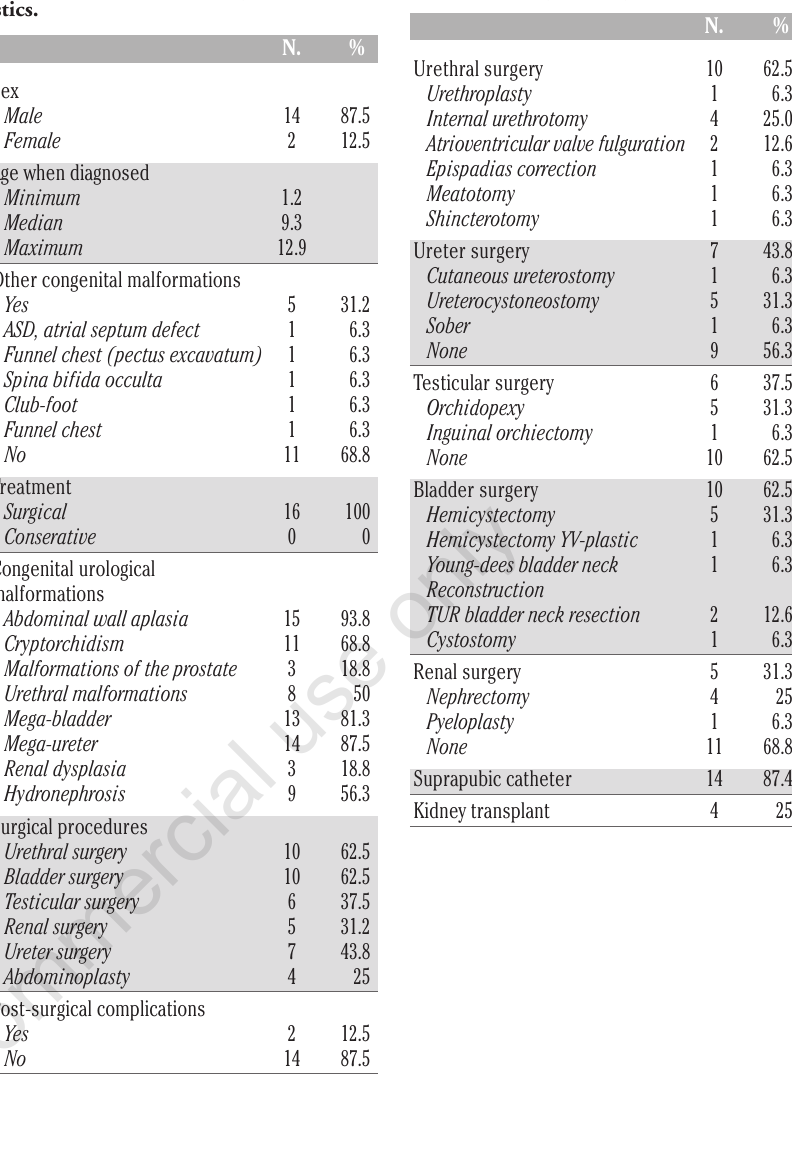
Table 2. Urological surgical procedures.